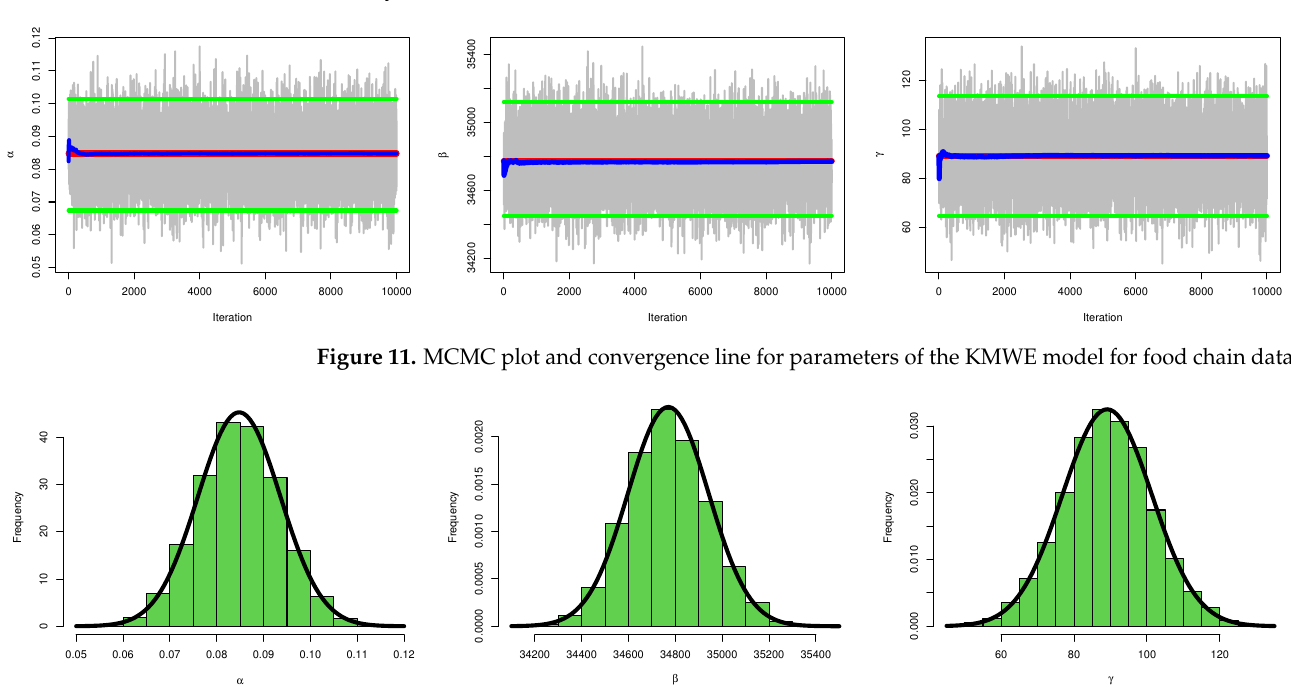
Figure 12. Histogram plot with normal curve for parameters of the KMWE model for food chain data. Table 9. Estimates of MLE and various measures of fit for food and drink wholesaling